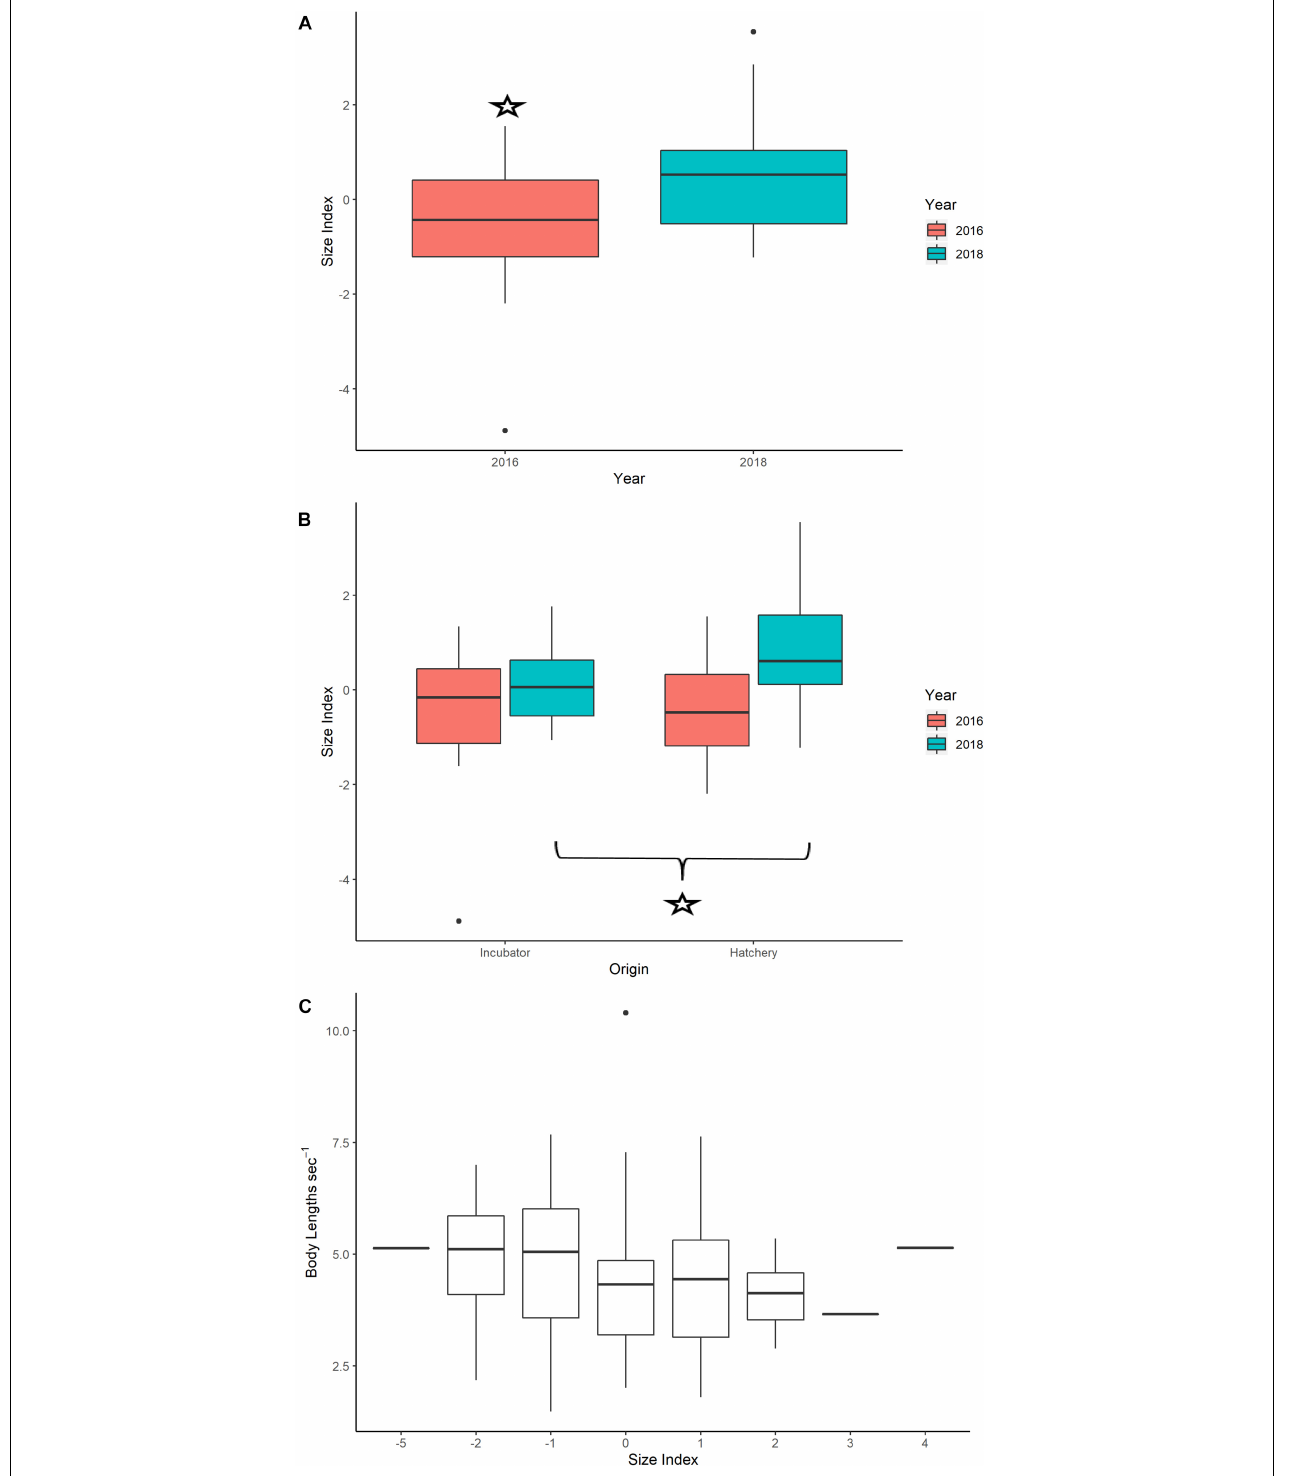
FIGURE 5 | (A) Boxplots of the size index for neonates in 2016 versus 2018, with a star indicating a significant difference between years using an independent t -test ( p -value < 0.05). (B) Boxplots of the size index for 2016 and 2018, with the star showing significant differences between incubator and hatchery individuals using an independent t -test ( p -value < 0.05). (C) Boxplots comparing body size index values versus average true swimming speed for neonates, standardized by body lengths per time (m s − 1 ). Results from a linear mixed effects model did not indicate significance for this relationship, even when controlling for variability in body size index with treatment (hatchery or incubator) and